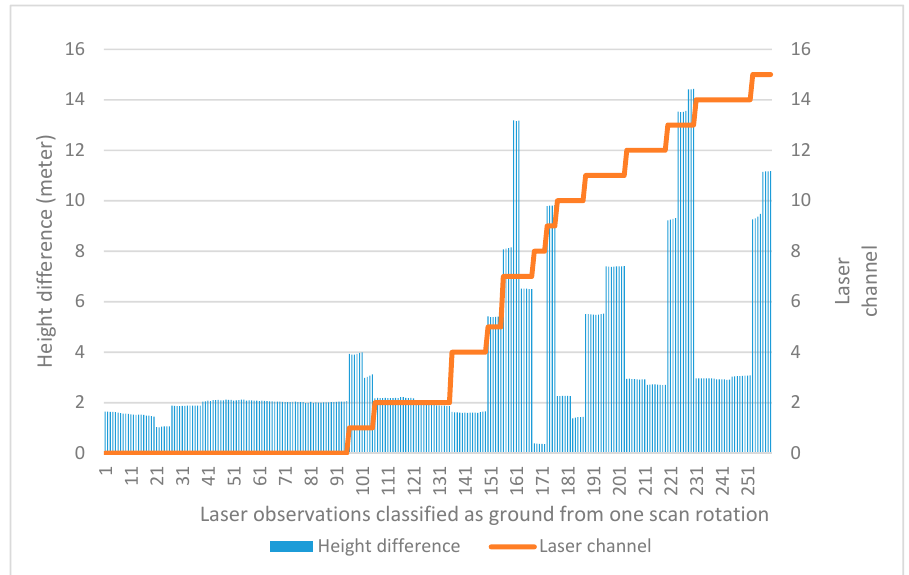
Figure 5. The height difference between the airborne laser scanning (ALS) ground points and terrestrial laser scanning (TLS) ground points was compared and evaluated based on the 16 different laser channels of the Velodyne laser scanner. The blue bars give the height difference between the ground classified points from TLS data and ground classified points from the ALS data. The orange line tells which laser channels are associated with the corresponding blue bar. The figure shows that laser channels pointing down are more likely to hit the true ground level.